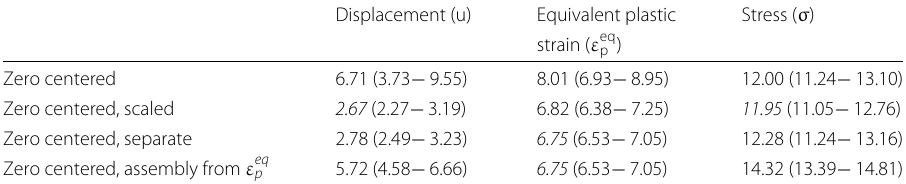
Table 6 Mean of the total reconstruction RMSRE ( · 10 − 2 ) using a full basis ( K = 79) over 5 training